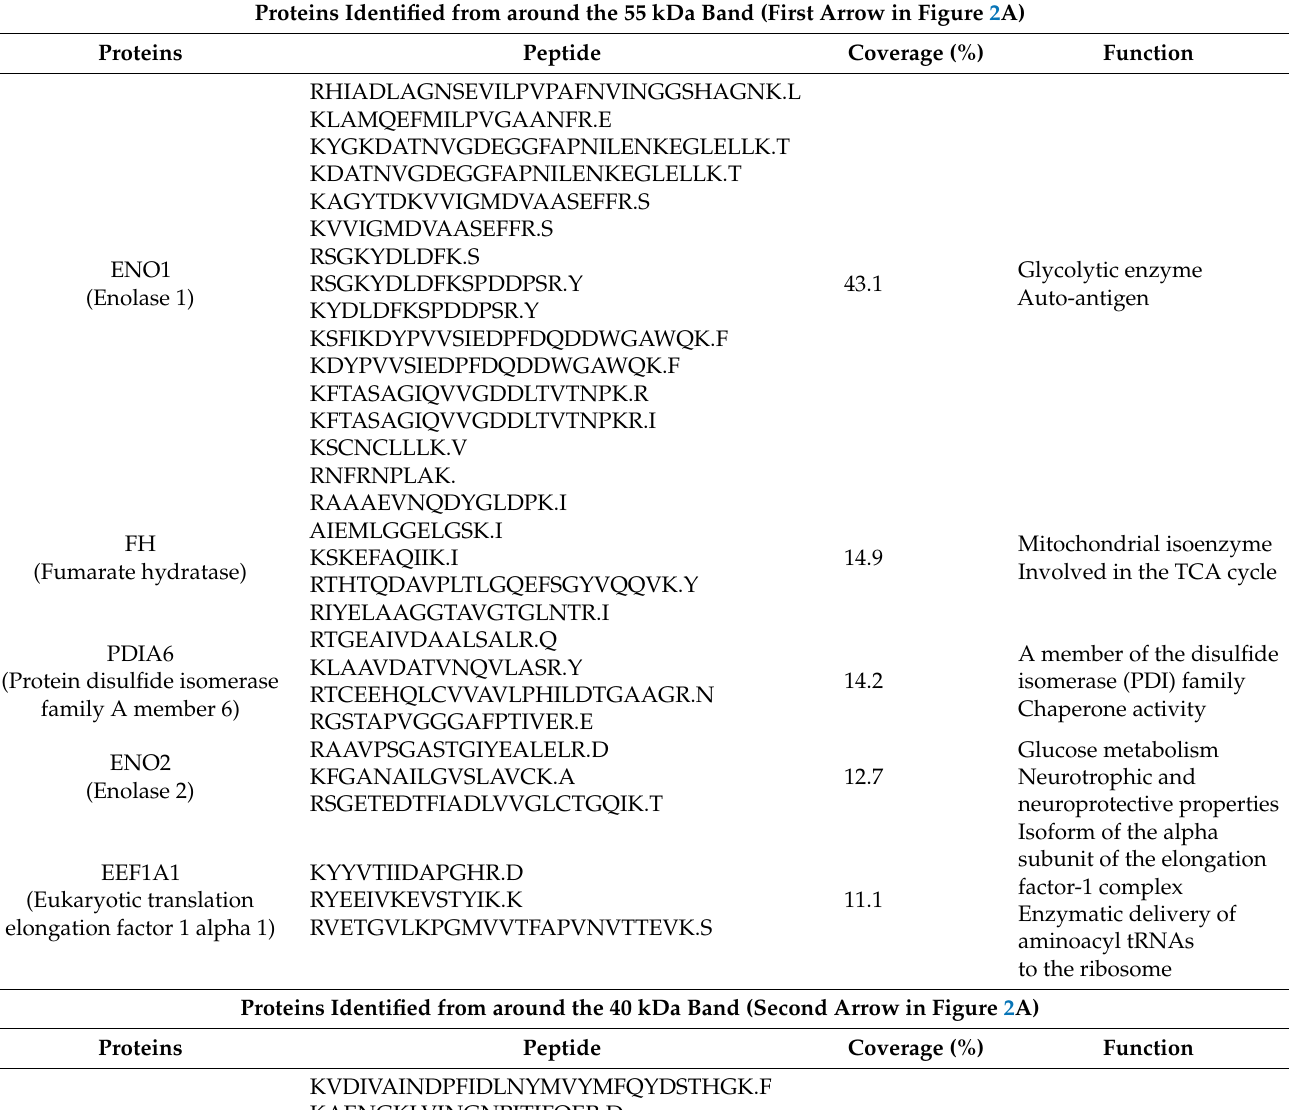
Table 1. Identification of MSPA-interacting proteins via mass spectrometry. Proteins Identified from around the 55 kDa Band (First Arrow in Figure